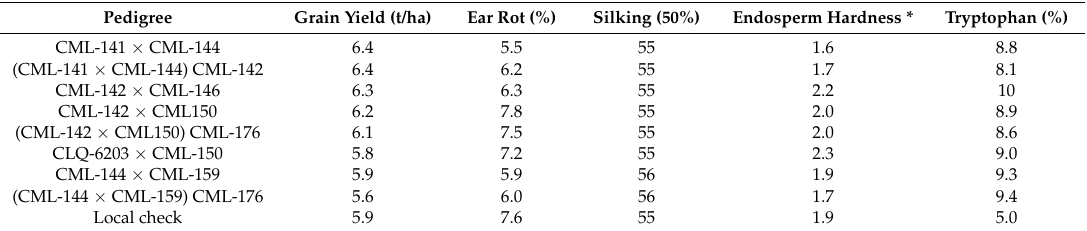
* Rating scale: 1–5 with 1 = completely hard and 5 = completely